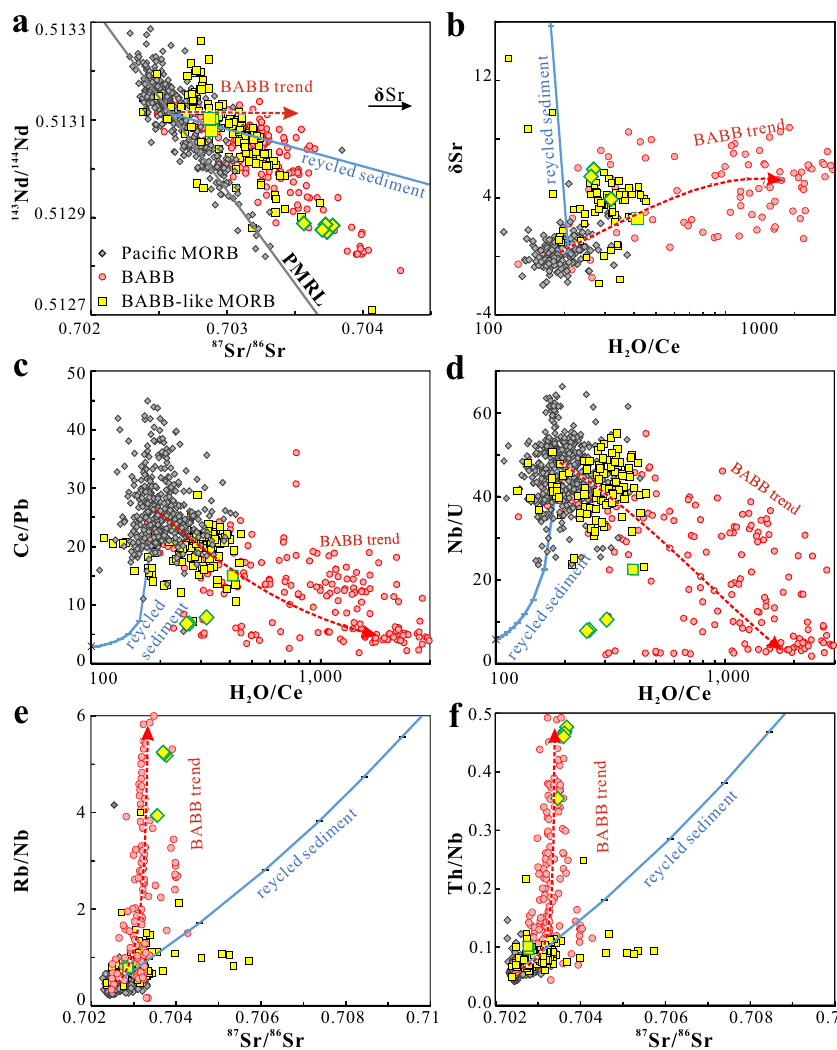
Fig. 6 Chemical characteristics of mid-ocean ridge basalts with back-arc signatures. a 87 Sr/ 86 Sr vs. 143 Nd/ 144 Nd, and b δ Sr (deviation of 87 Sr/ 86 Sr relative to the Paci fi c mid-ocean ridge basalts (MORB) reference line (PMRL), details of this line can be found in the Methods section) vs. H 2 O/Ce ratios, c , d H 2 O/Ce vs. Ce/Pb, and Nb/U, e , f 87 Sr/ 86 Sr vs. Rb/Nb, Th/Nb, and for Paci fi c MORB, back-arc basin basalts (BABB), and BABB-like MORB. The BABB- like MORB have higher H 2 O/Ce, and Th/Nb and shift to higher 87 Sr/ 86 Sr relative to 143 Nd/ 144 Nd ratios than Paci fi c MORB. Red curves show the BABB trends, indicating the direction for subduction input. Blue curves show the trends for mixing recycled sediments in Paci fi c MORB mantle with 1% increments. Paci fi c MORB mantle compositions were calculated assuming the average Paci fi c MORB are formed by ~10% melting of their source mantle, and the global subducting sediment compositions 30 were used as the recycled sediment endmember with a H 2 O/Ce ratio of 100 (details on the H 2 O/Ce estimation can be found in the Methods section). Recycled sediment fails to account for the characteristics of most BABB-like MORB. Data source can be found in the Supplementary Data